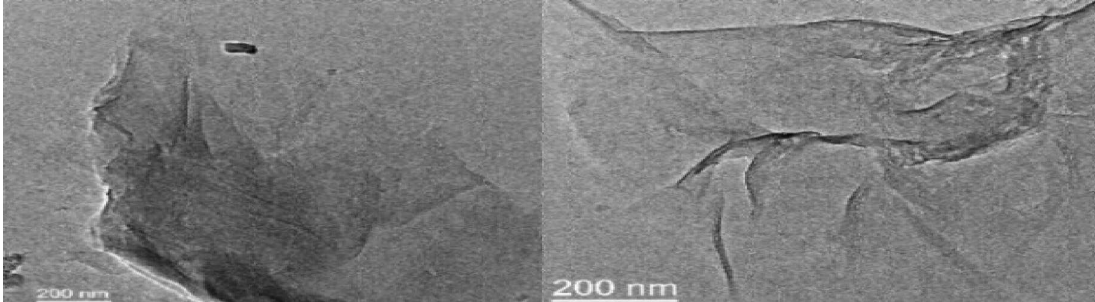
Figure 1. HR-TEM images of GO and GO after 5th run.